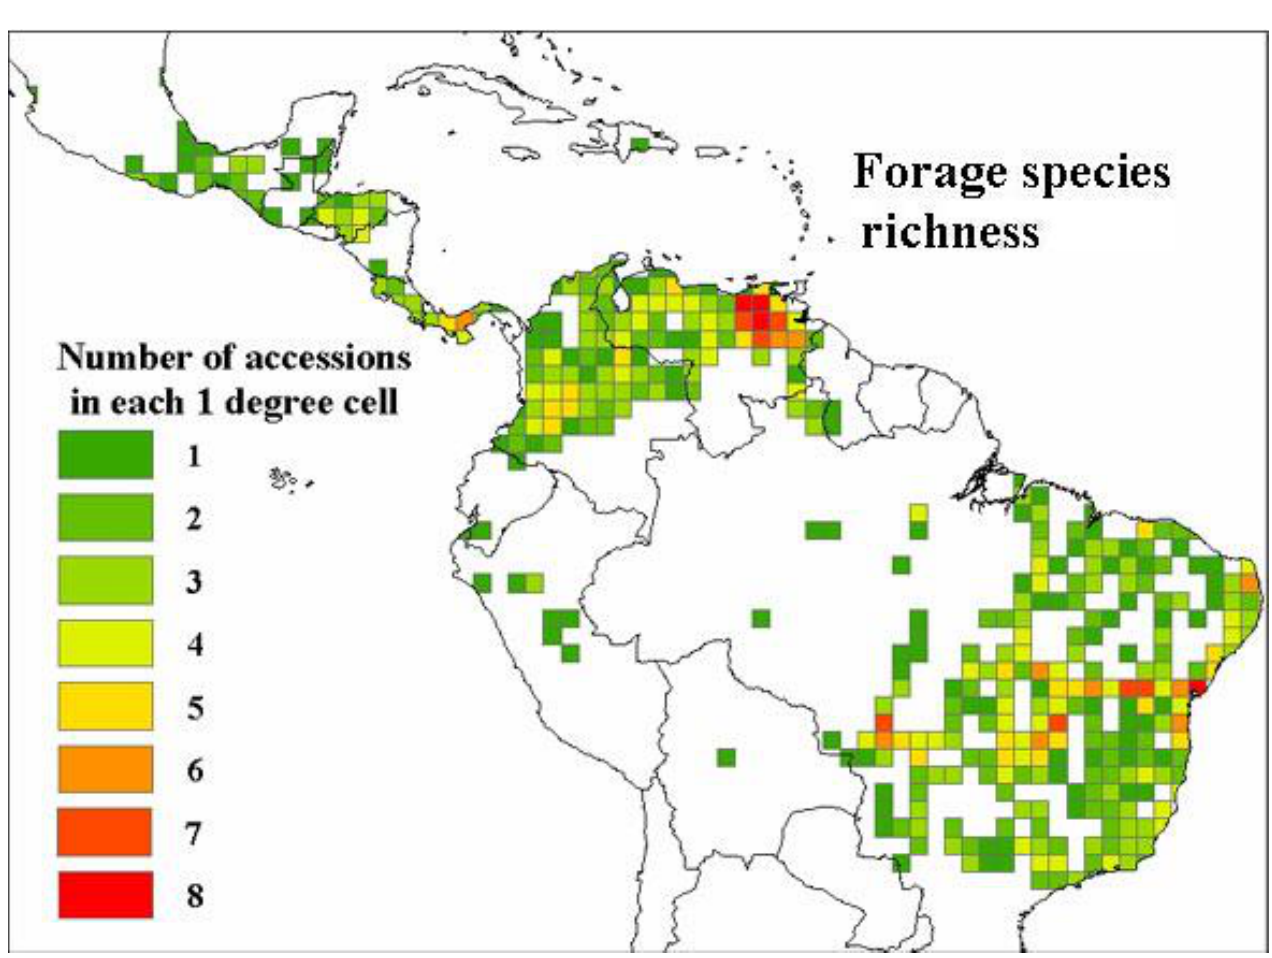
Fig. 3 . Species richness of 10 forage species in Latin America.